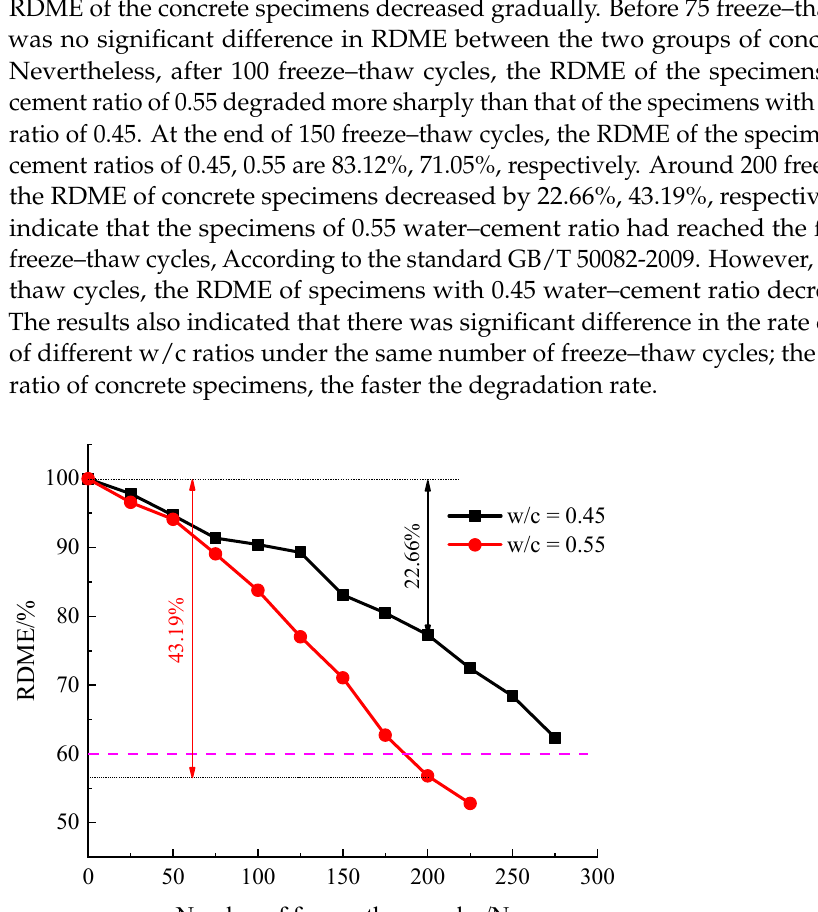
( b ) Figure 11. Dynamic compressive strength with different freeze–thaw cycles. ( a ) w/c = 0.45 and ( b ) w/c = 0.55.